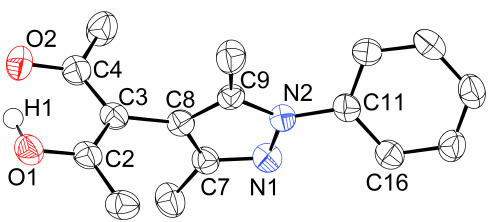
Figure 3. Displacement ellipsoid plot [30] of one molecule in the asymmetric residue of 1 (80% probability, C bonded hydrogens omitted). Selected intramolecular distances and angles (Å, °): O1–C2 1.311(2), O2–C4 1.278(2), C2–C3 1.395(3), C3–C4 1.424(3), C2–C3–C8–C9 85.7(2), N1–N2–C11– C16